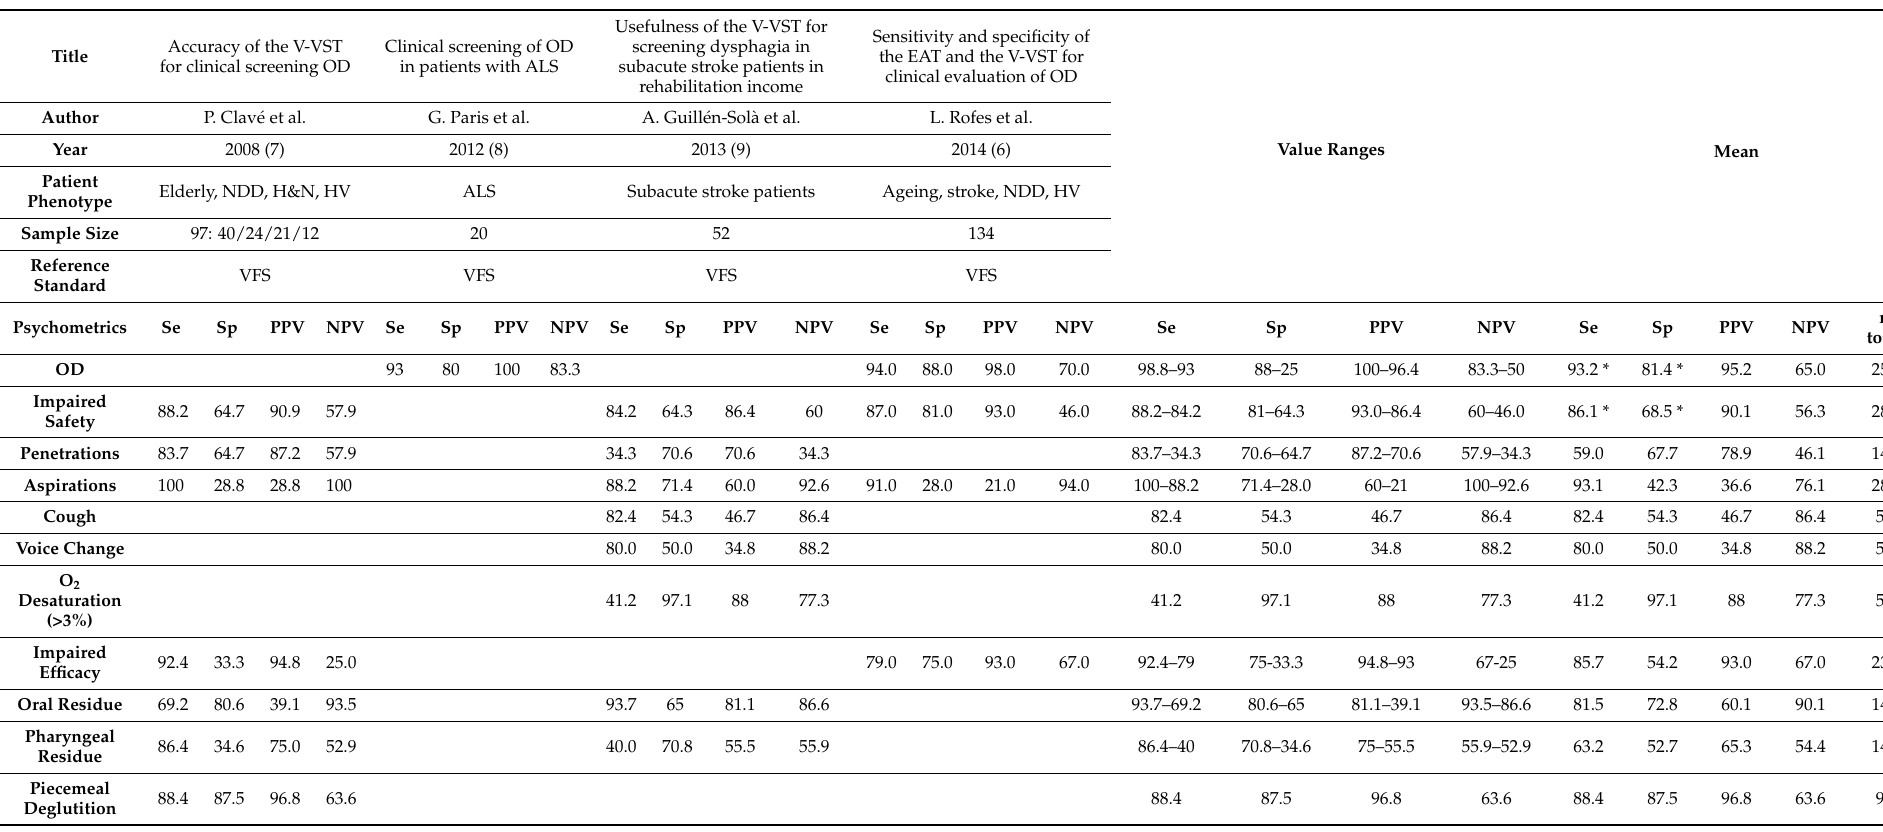
Table 2. Summary table of the psychometric properties of the volume-viscosity swallow test (V-VST) for oropharyngeal dysphagia (OD) and all the clinical signs of impaired safety and efficacy of swallow evaluated with the test reported in each of the included studies in the systematic review (SR). Each of the reported studies included information on the phenotype of patients, sample size of the studies, and reference standard